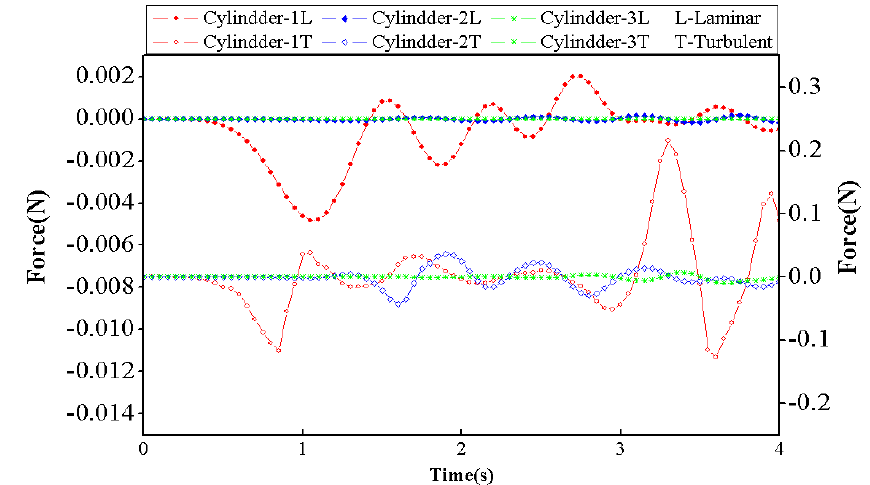
Figure 13. Normal disturbance force–time curve of laminar flow and turbulence